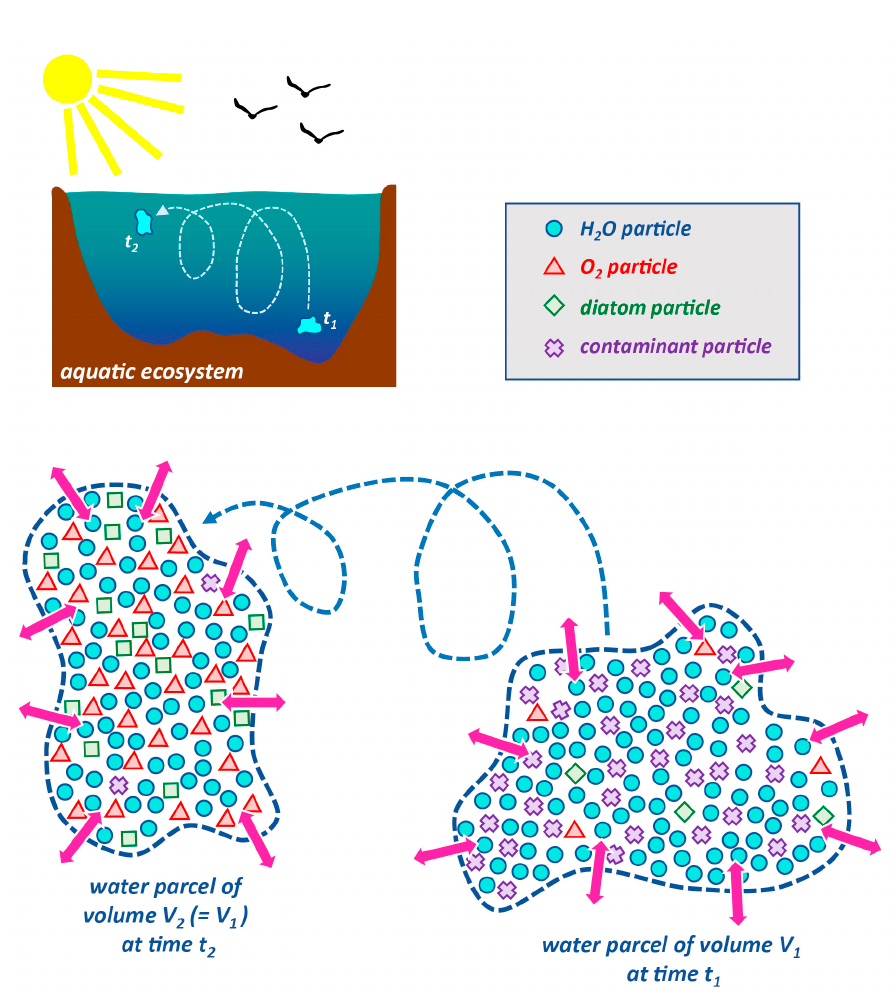
Figure 2. Cartoon depicting a water parcel as it is transported through an aquatic ecosystem between times t 1 and t 2 . The water parcel’s volume is constant, but its shape is not. Due to diffusion (magenta arrows), the particles contained within the parcel at t 2 are not the same as the particles contained in the parcel at t 1 . Each “particle” is composed of multiple molecules, atoms, or cells of a particular constituent or aggregate. (Following Deleersnijder et al. [63]).